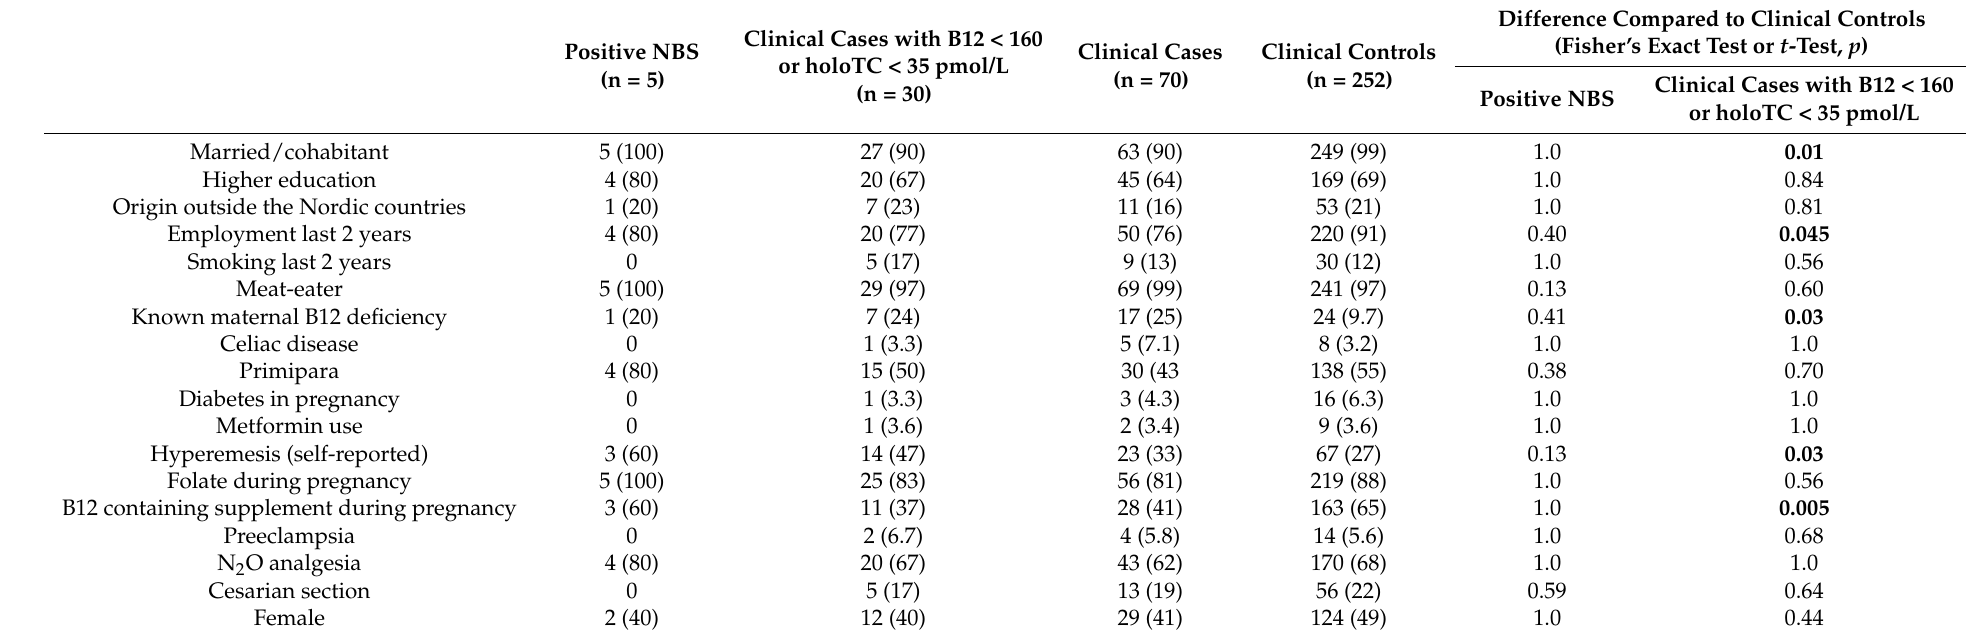
Table 2. Descriptive characteristics of clinical cases and controls, mean (SD) and n